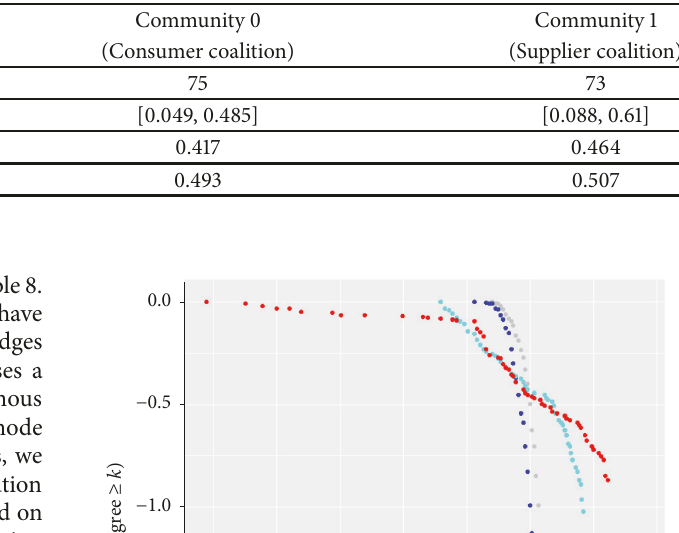
Table 7: Mixing parameters in detected communities in the yes network.